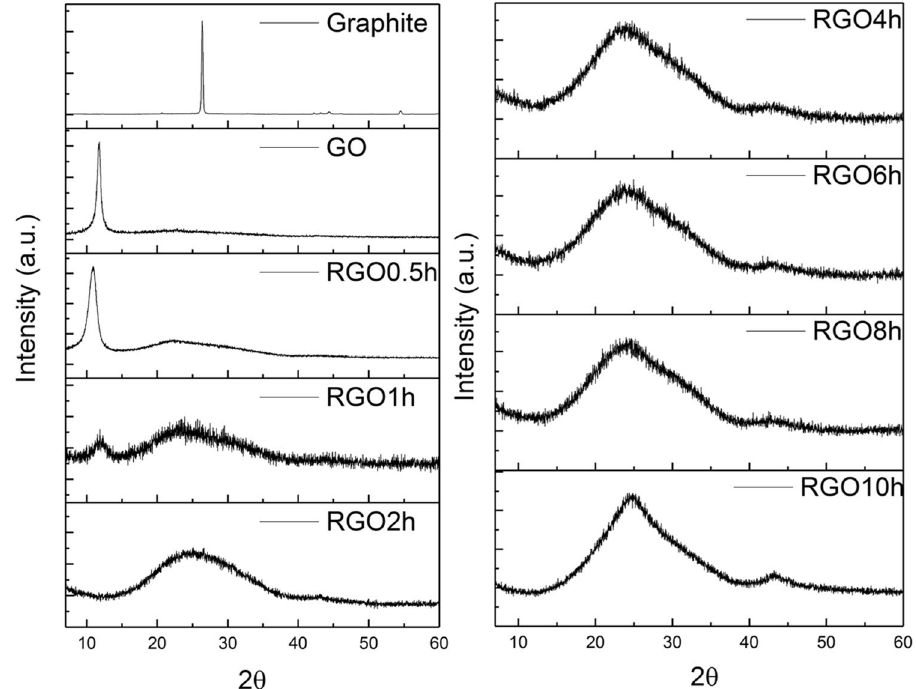
Figure 1. XRD patterns of graphite, GO, and rGO samples treated at different hours.